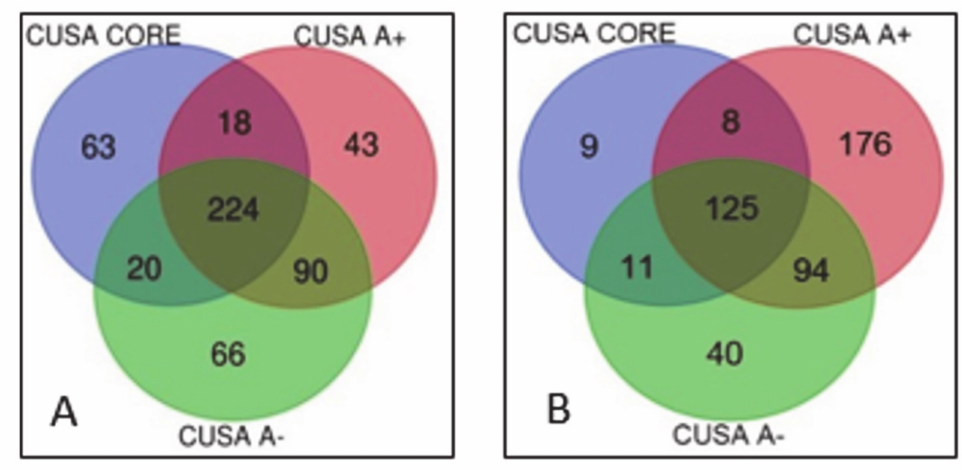
Figure 1. Identified proteins Venn diagram sample grouping in ND (panel A) and R (panel B) GBM